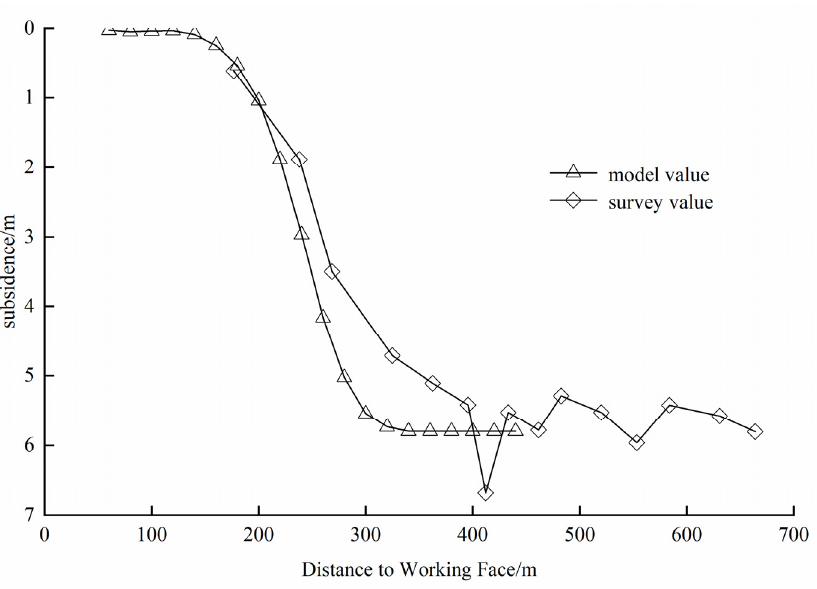
Figure 10. The subsidence velocity between the numerical modeling and the survey data.